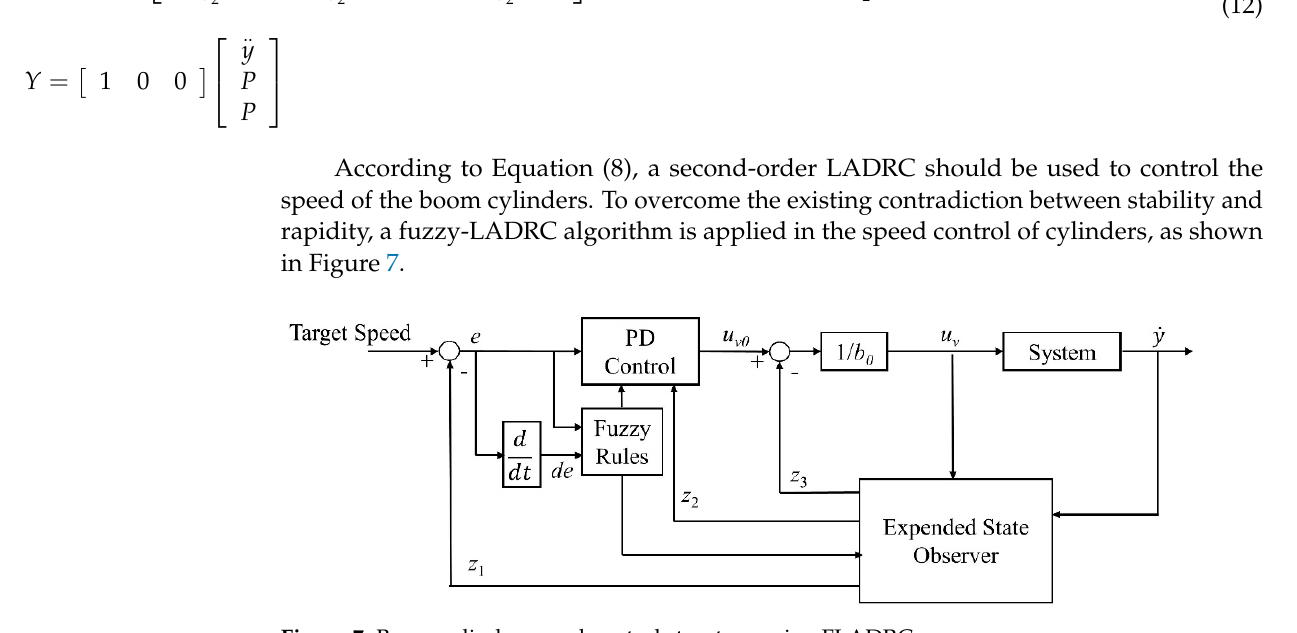
Figure 7. Boom cylinder speed control structure using FLADRC.